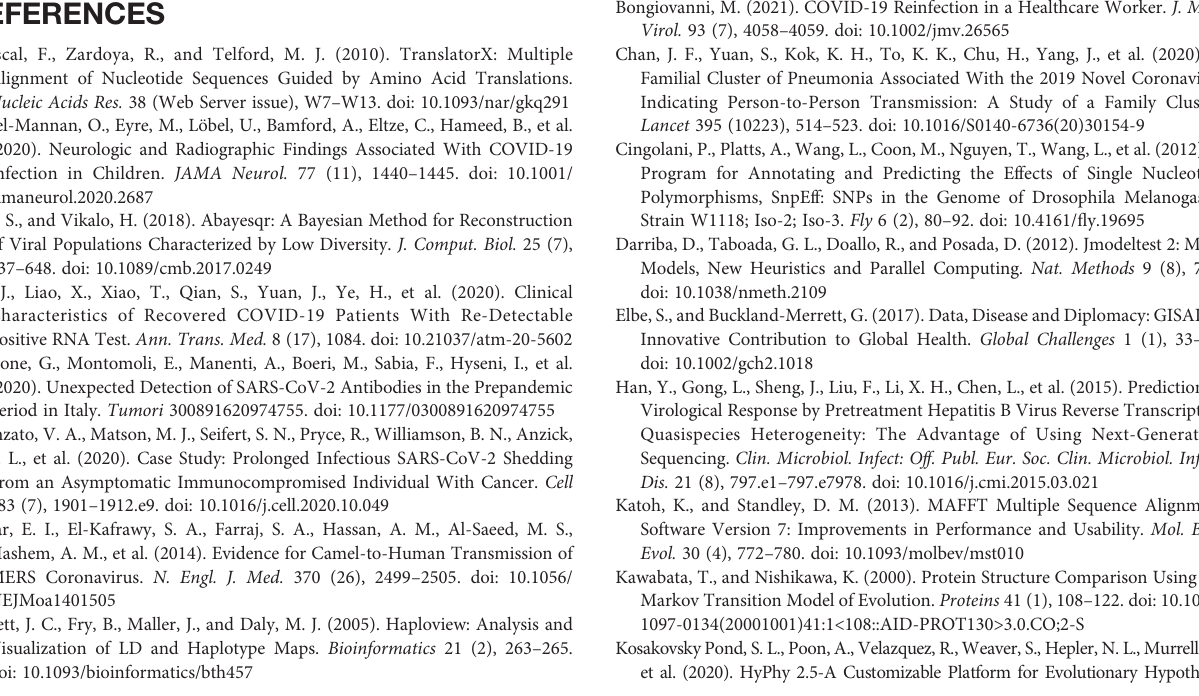
Supplementary Figure 1 | Kinetic analysis of the serum levels of in fl ammatory cytokinesinCOVID-19patients.TheconcentrationsofIL-2 (A) ,IL-4 (B) ,IL-6 (C) ,IL- 10 (D) , IFN- g (E) , and TNF- a (F) in the serum of COVID-19 patients YW01 (red line), YW02 (grey line), and YW03 (blue line) were analyzed at different time points during two hospital admissions. The dotted green line divides the whole course into fi rst and second episodes. Supplementary Figure 2 | Comparison ofthe predicted ternary structures for the WT (in green) and the mutant (in blue) of SARS-CoV-2 proteins. The mutated sites were colored in